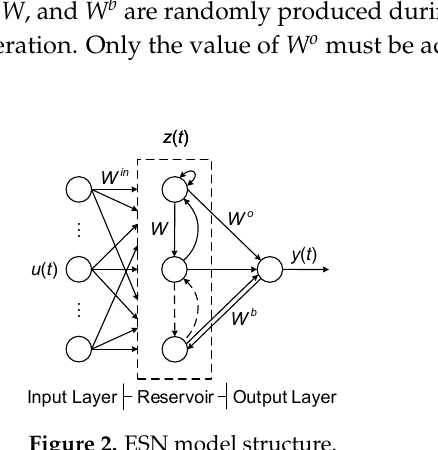
Figure 2. ESN model structure.